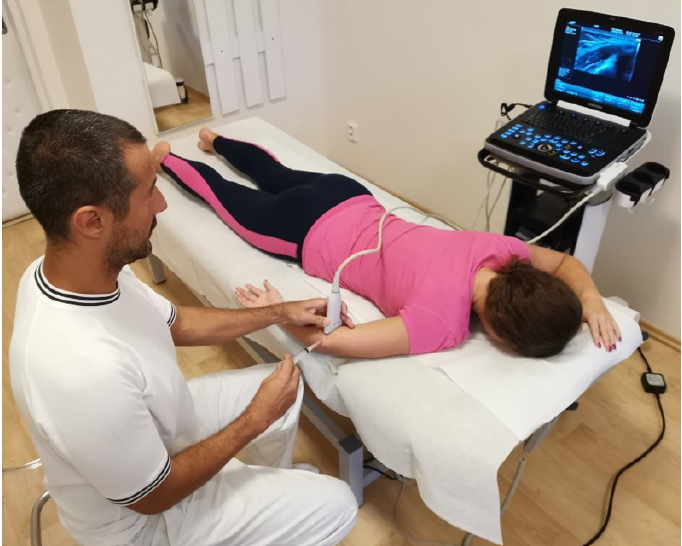
Figure 7. Prone position for the ultrasound-guided golfer’s elbow injection with the elbow flexed and forearm pronated while supported on the examination